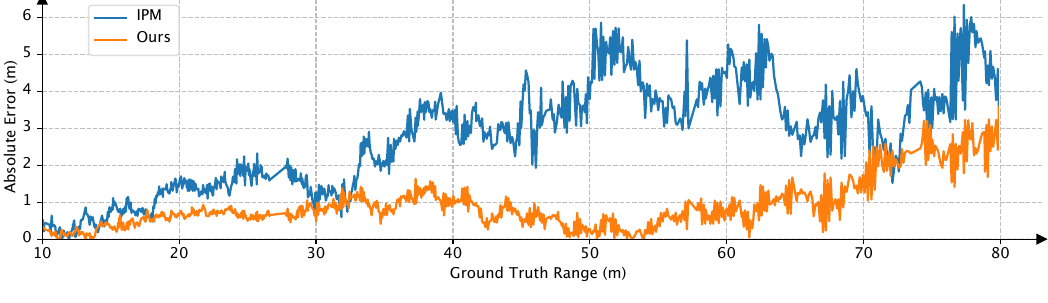
Figure 11. Performance on a data sequence collected by our autonomous driving